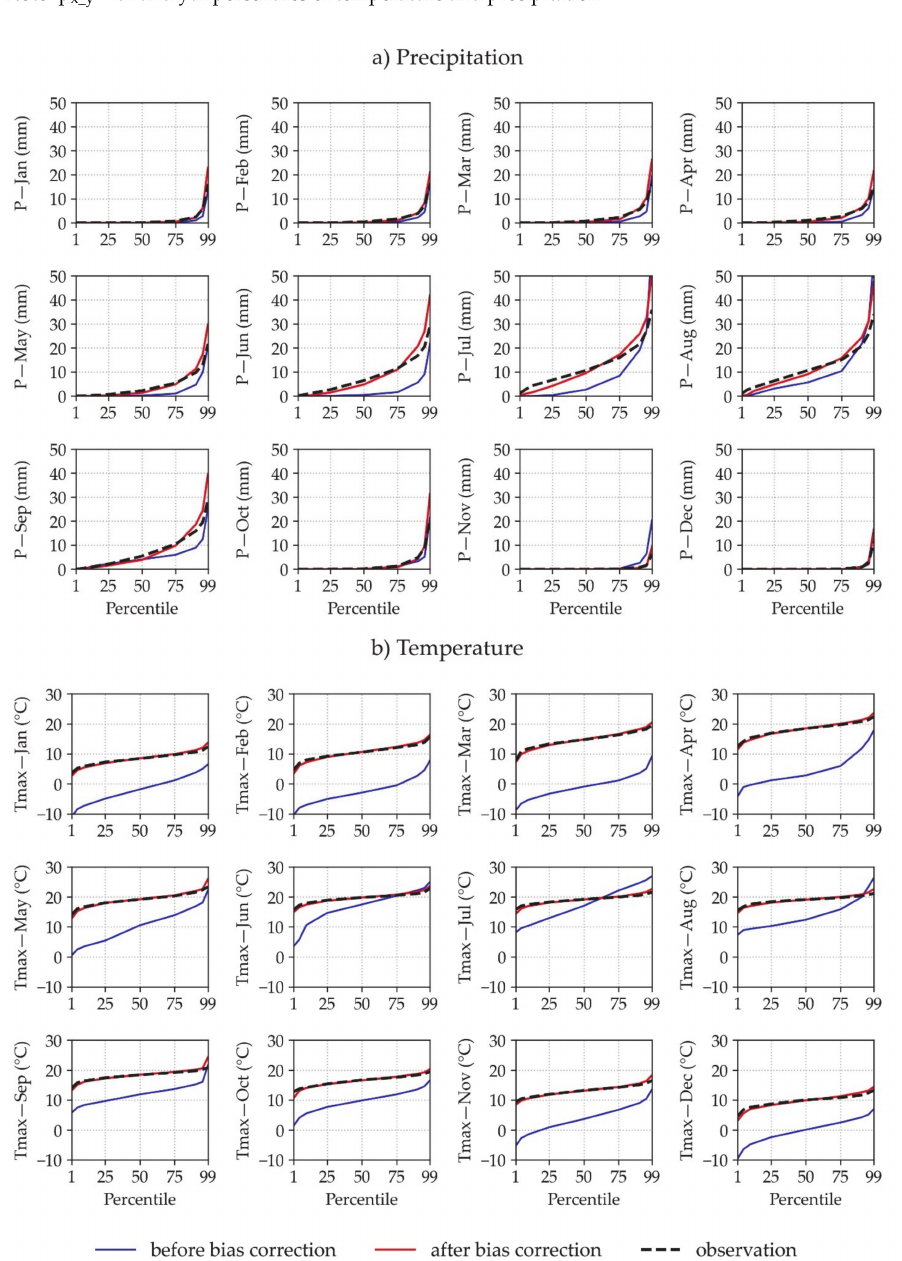
Figure 4. Observed (black), before bias correction (blue), and after bias correction (red) precipitation (top) and maximum temperature (bottom) monthly values for RCP 4.5 of